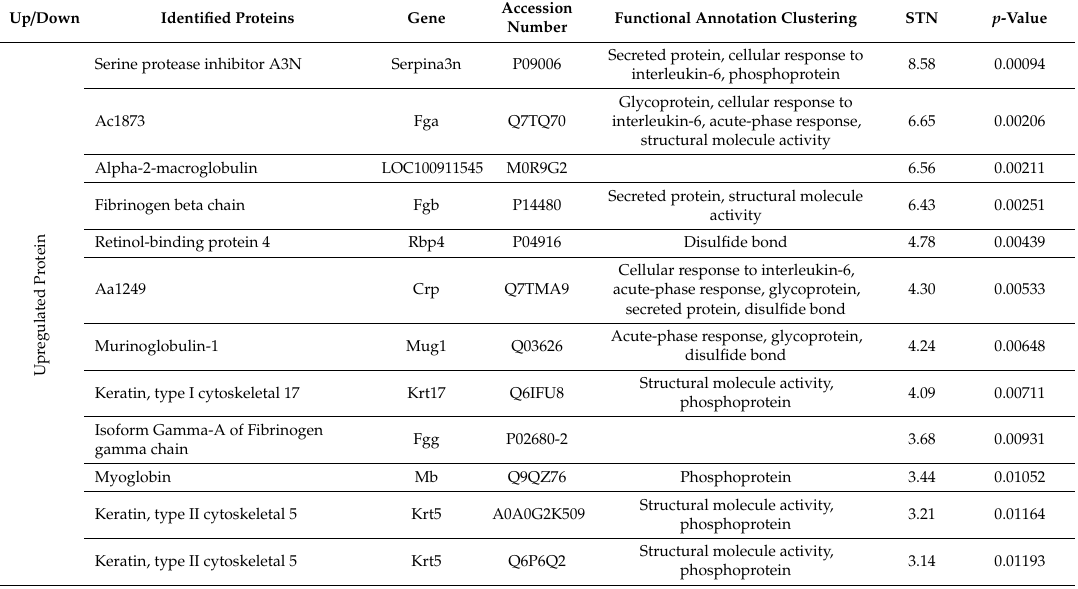
Table 1. PLGEM here is the power law global error model. Table 1. Selected biosignature candidate proteins identified in the serum of the aged rat treated with non-saponin fractions with rich polysaccharide